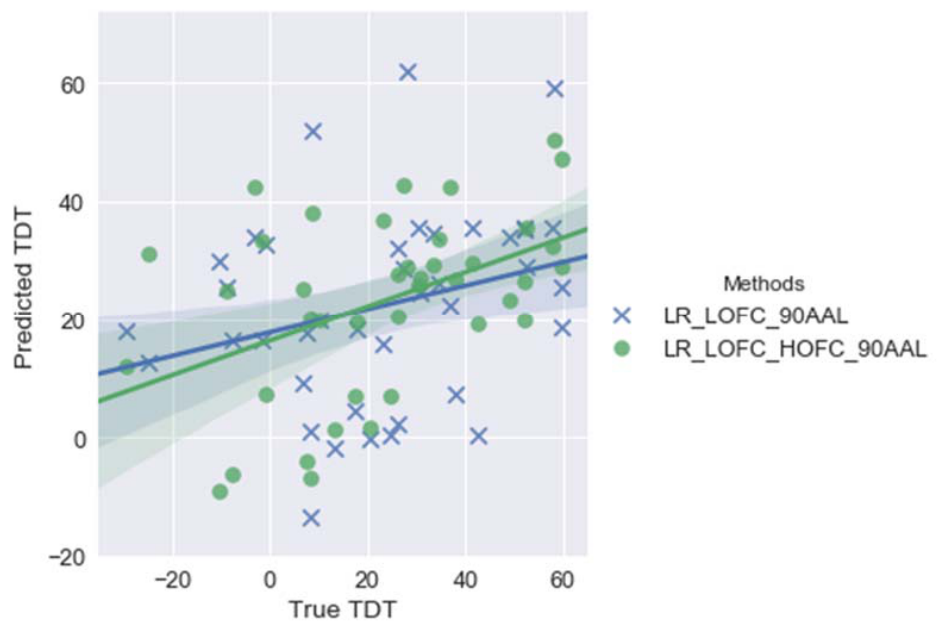
Figure 3. Plots of predicted vs. true Tactile Discrimination Test (TDT) scores by employing linear regression (LR) with either LOFC or LOFC + HOFC with feature pools (cerebellum excluded). Correlation coefficients, r , between predicted and true TDT scores are 0.45 and 0.28 for